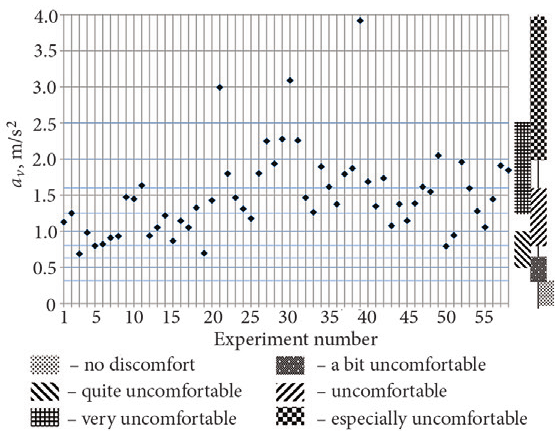
Figure 6. Effect of the analysed trapezoidal speed humps on driving comfort according to the LST ISO